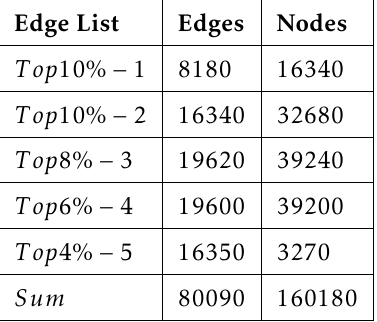
Table 3. Edge Lists of 10 Different Iterations for Each Centrality Measure i.e., indegree, outdegree, Betweeness, Closeness and